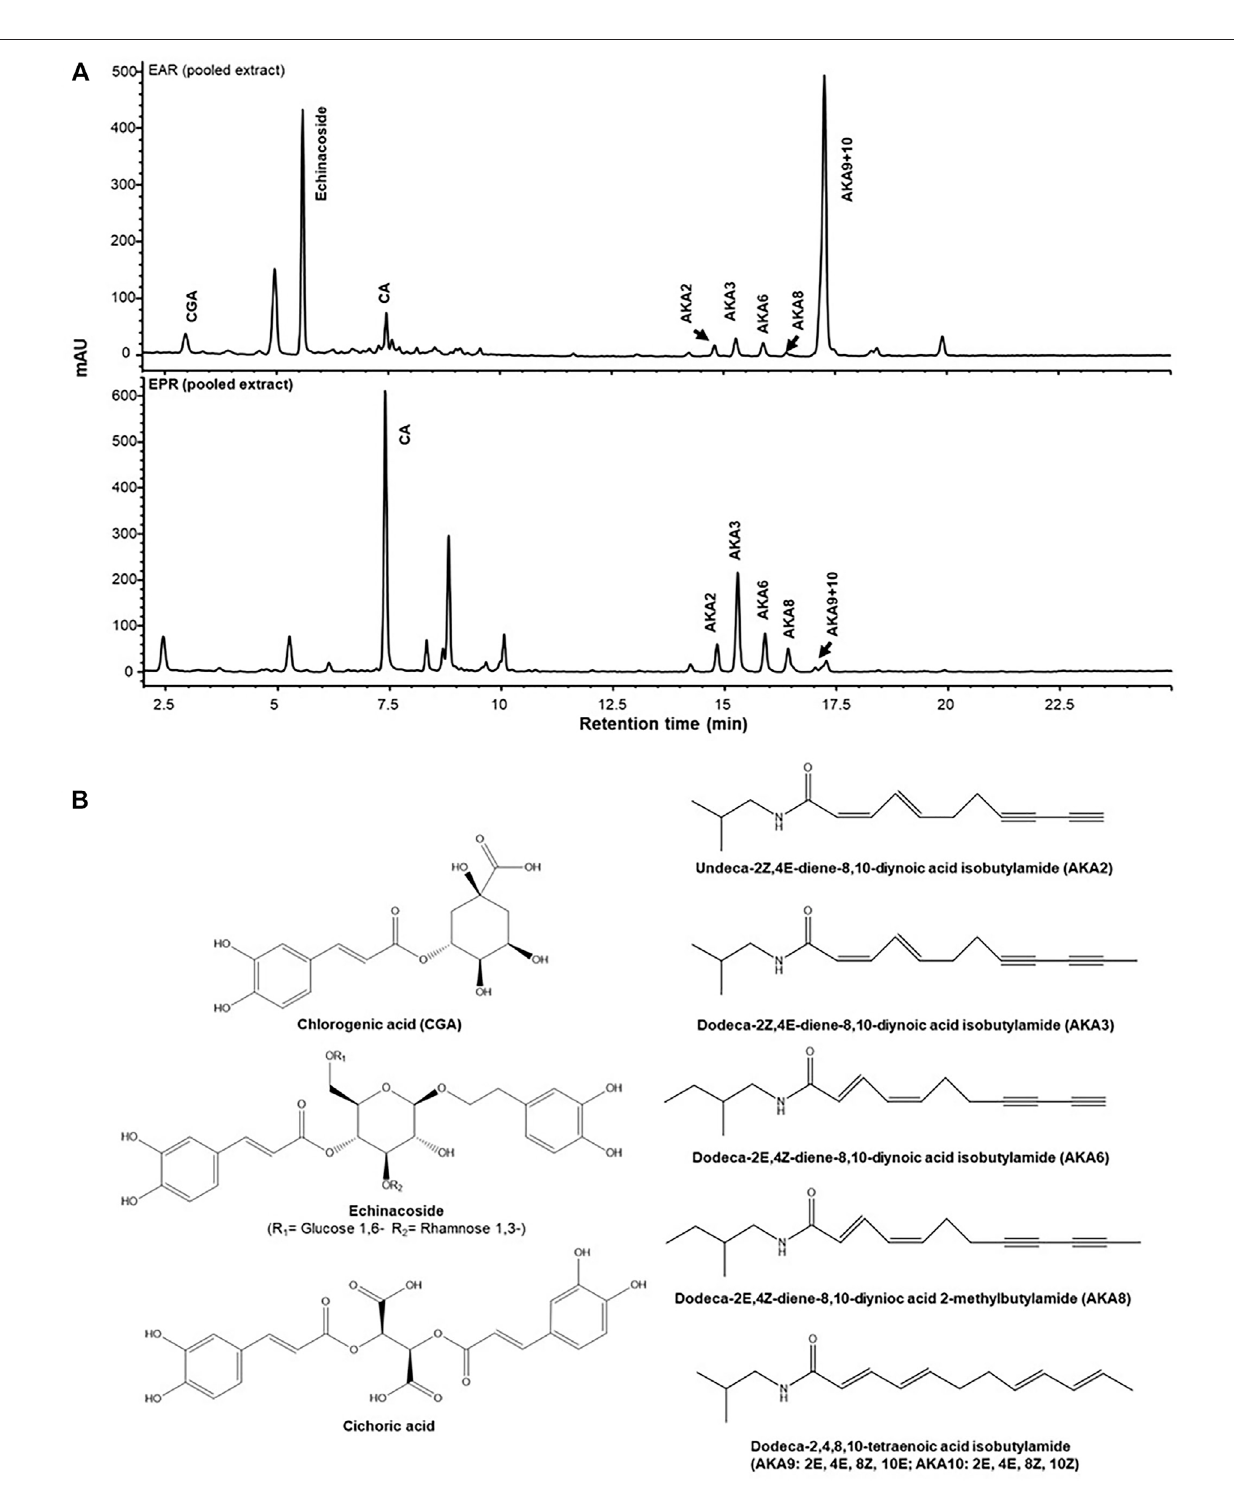
FIGURE 1 | Targeted identity analysis of E. purpurea (EPR) and E angustifolia (EAR) roots by HPLC-DAD-MS showing distinct phytochemical pro fi les for each species (A) .Quanti fi cationofthesemarkers, (B) withavalidatedmethodprovidesqualityassuranceforpharmacologicalstudies.ReproducedfromLiuR.,SalasN.C.,Li W.,Wang L.,ArnasonJ.T., HarrisC.S.Interactionsof Echinacea spp.rootextracts andalkylamides withtheendocannabinoidsystemandperipheralin fl ammatorypain. Frontiers in pharmacology. 2021 12:776. Reproduced under the terms of a CC BY 4.0 license https://creativecommons.org/licenses/by/4.0/.